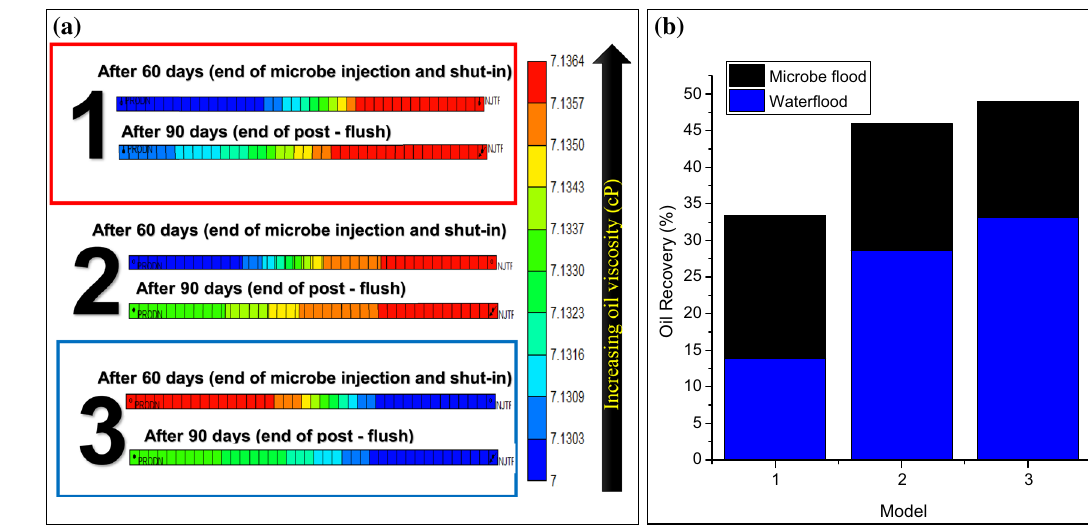
Fig. 4 a Oil viscosity variation per the different models and b oil recovery (%) per the different models considered